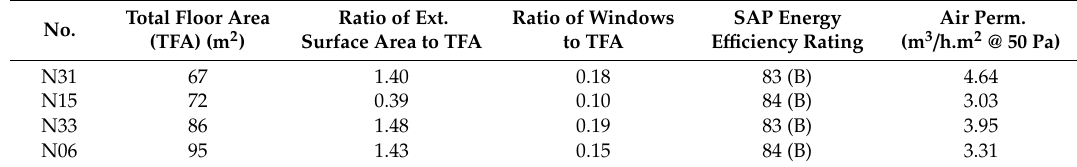
Table 2. Case study physical characteristics (in order of increasing total floor area).